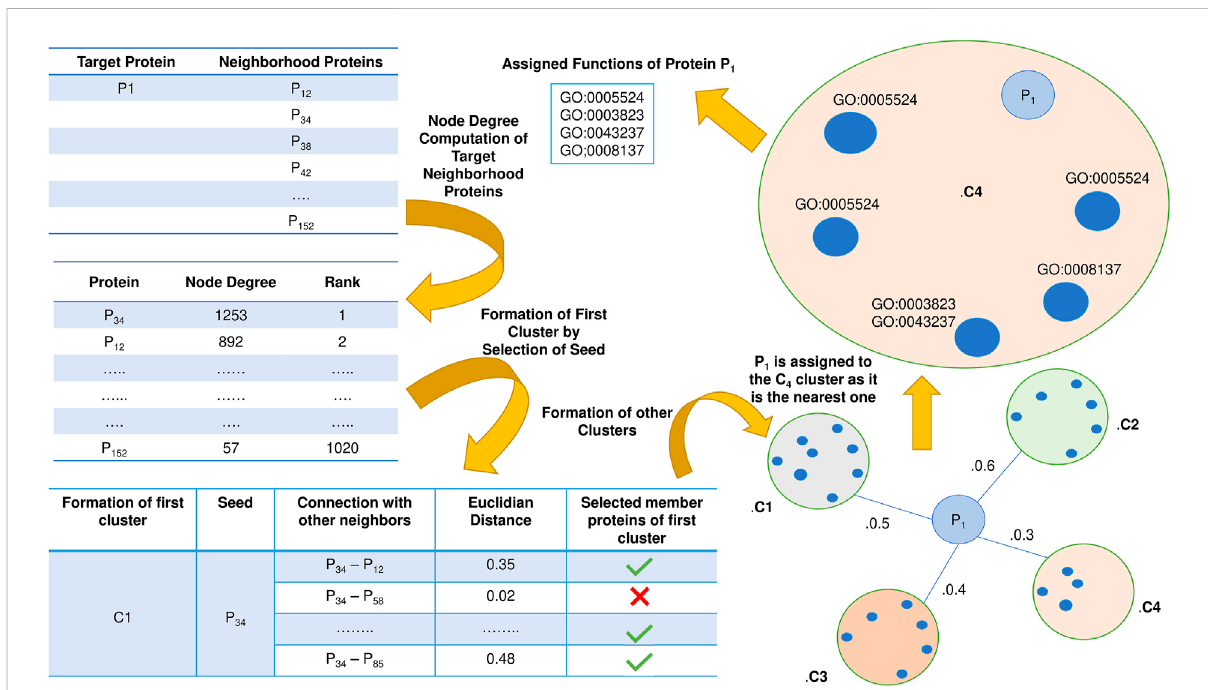
FIGURE 4 Schematic representation of Sequence-based protein function prediction. The essential aspects of this phase are the selection of seeds followed by the formation of clusters and computation of Physico-chemical properties.